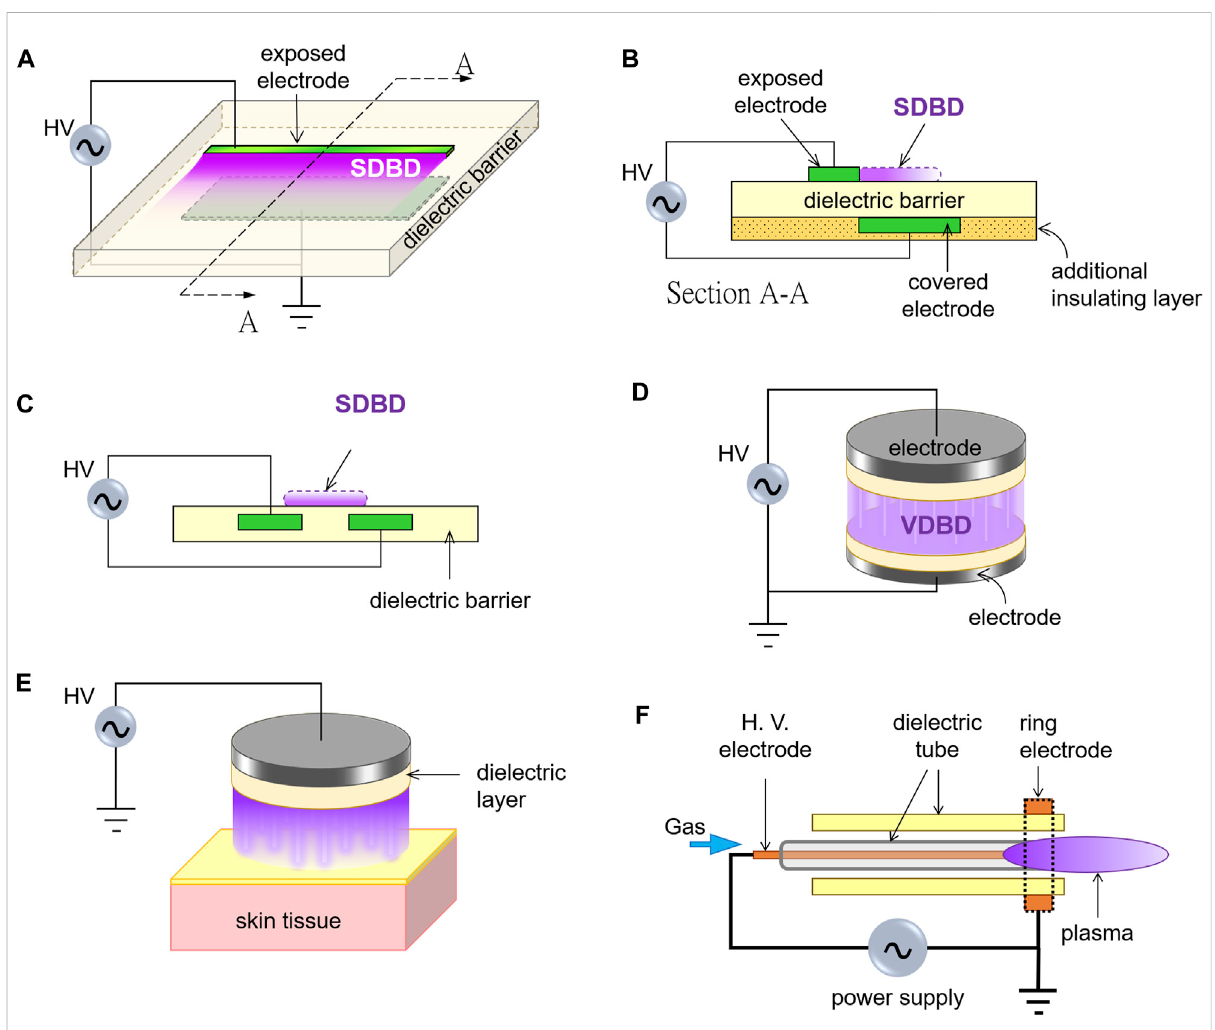
FIGURE 1 Types ofDBDPlasma Reactors. (A) Basiclinear SDBD con fi gurationwith plasmaalongtheborderoftheexposed electrode. (B) Cross-sectional viewofthelinearSDBDcon fi guration. (C) SDBDwithbothelectrodesburiedinthedielectric. (D) VDBDwithbothelectrodescoveredwithadielectric layer. (E) Floating-electrode DBD (FE-DBD). (F) An example of plasma